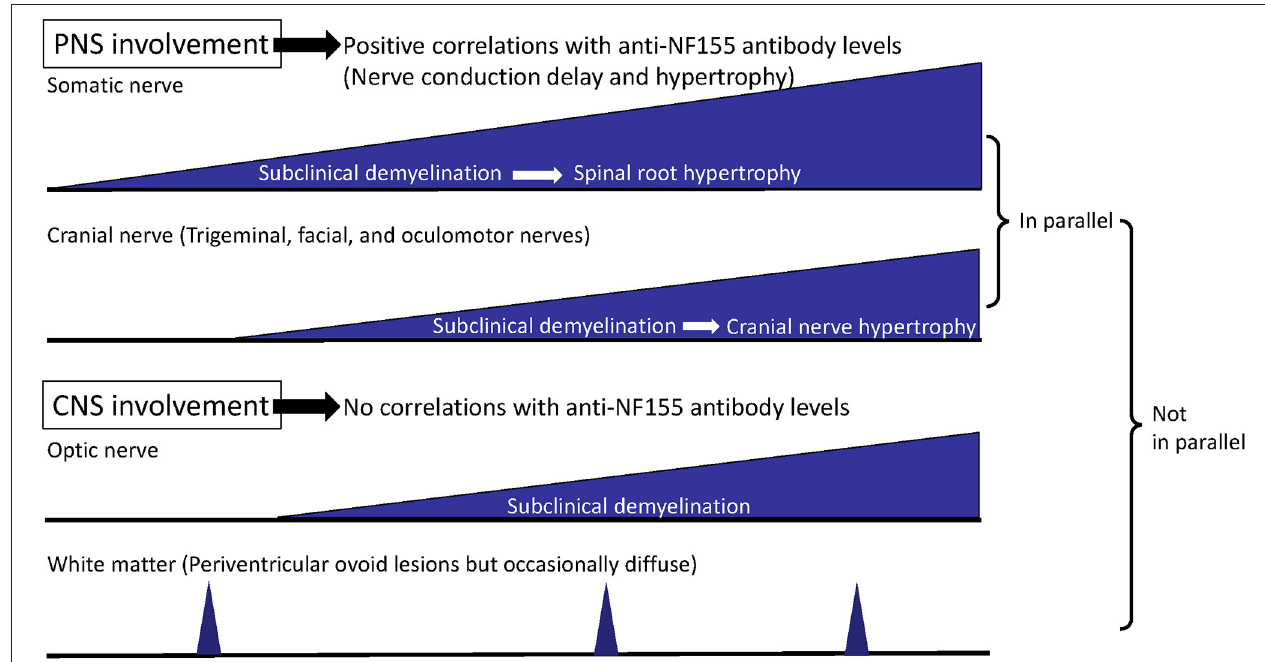
FIGURE 3 | Process of disease progression in NF155 + chronic inflammatory demyelinating polyneuropathy (CIDP)/combined central and peripheral demyelination (CCPD). In NF155 + CIDP/CCPD, the disease initiates (subclinical) demyelination at the distal nerve terminals of the somatic nerve and then extends to the cranial nerves. Later, hypertrophy of the proximal spinal nerve and roots occurs over the long disease duration, which is followed by hypertrophy of the cranial nerves, such as trigeminal and oculomotor nerves. Somatic and cranial nerve involvements develop in parallel except for the optic nerve, while peripheral nervous system (PNS) and central nervous system (CNS) involvements do not occur in